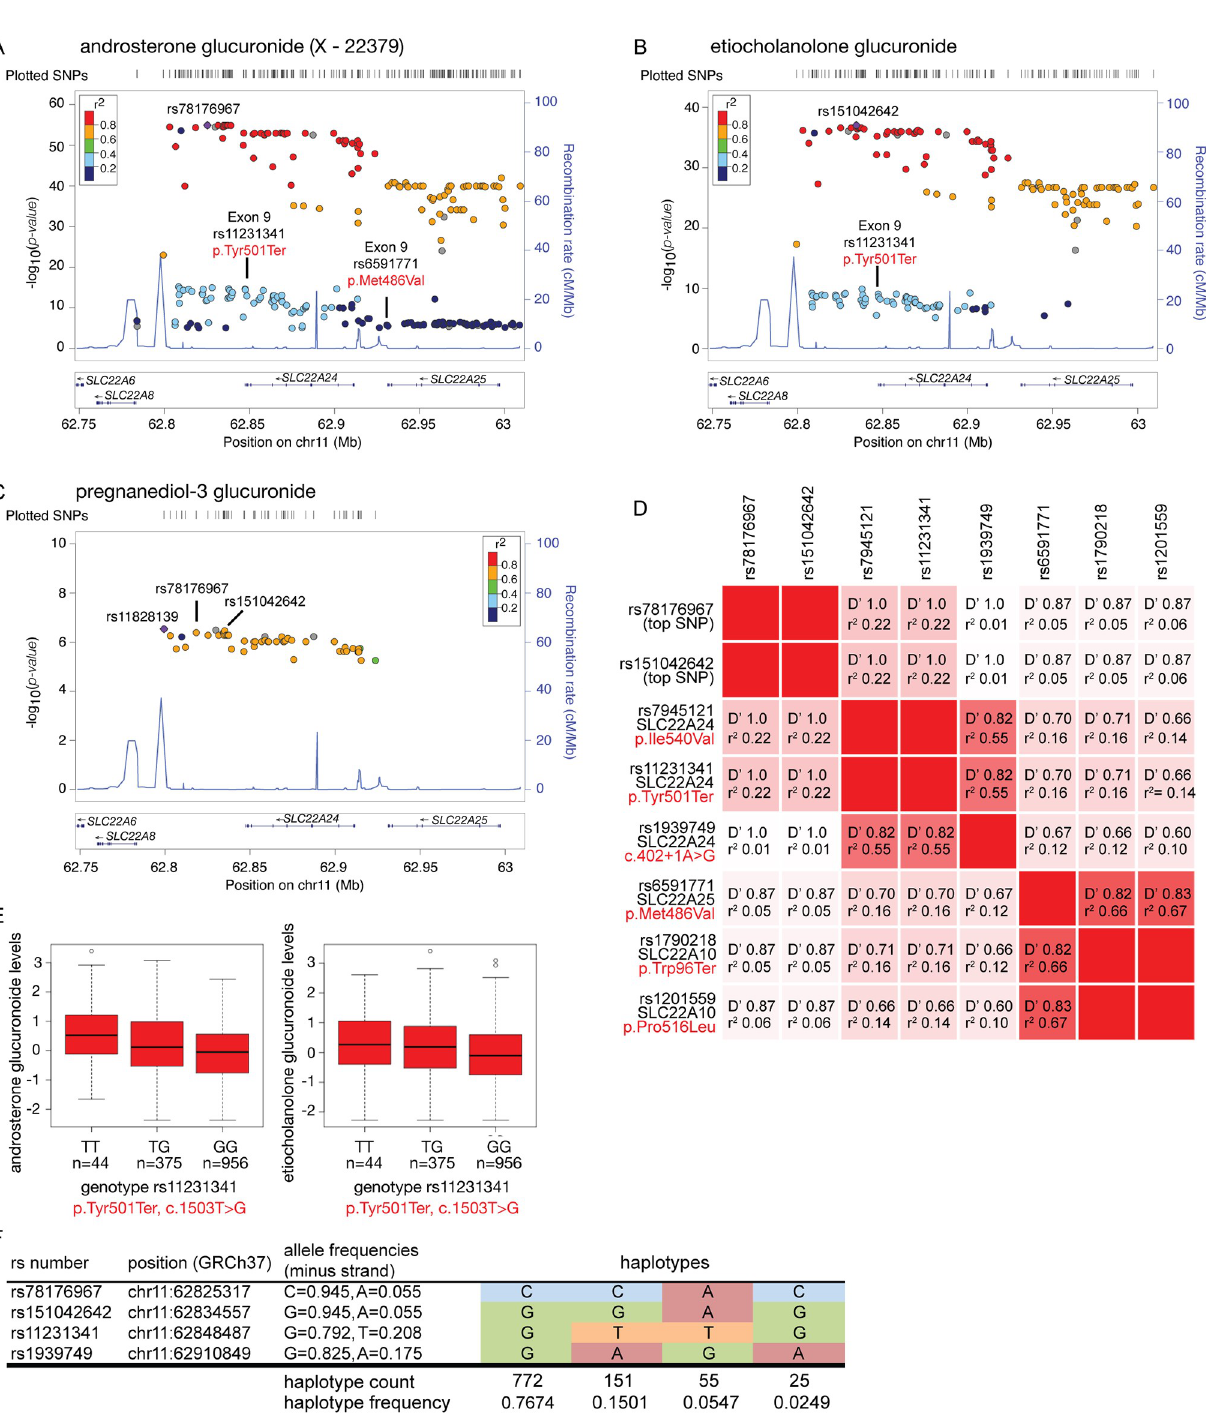
PLOS Genetics | https://doi.org/10.1371/journal.pgen.1008208 September 25,